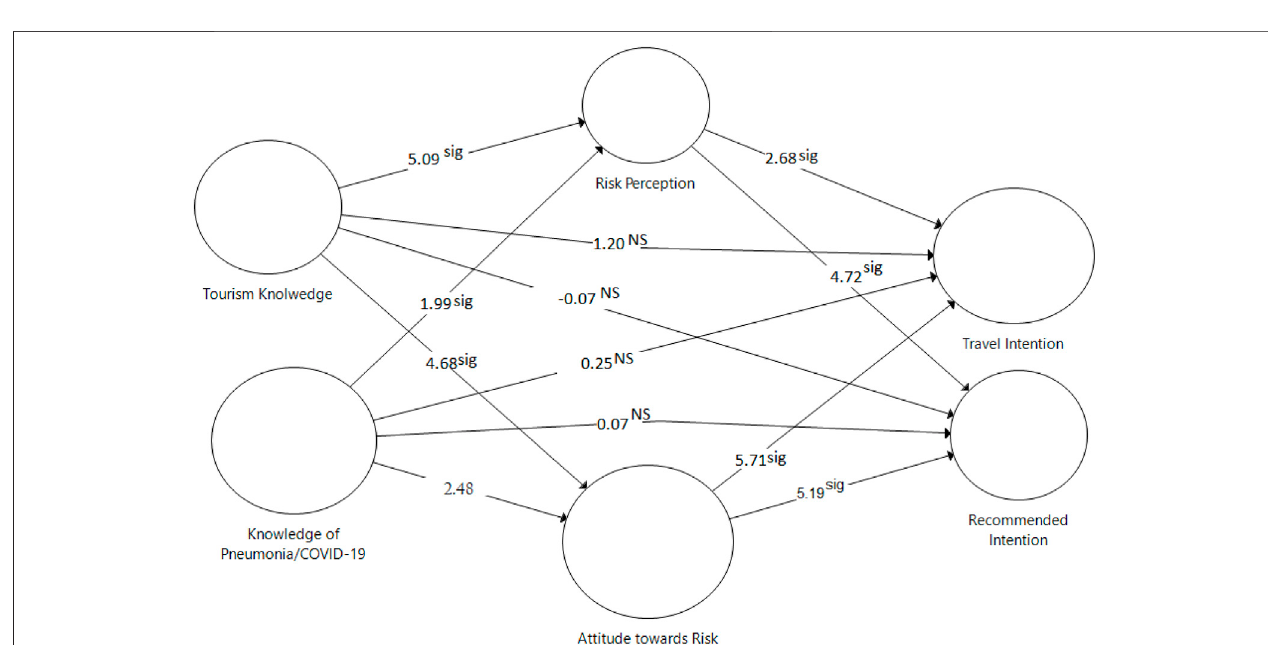
FIGURE 3 | Mediation Analysis SEM output.